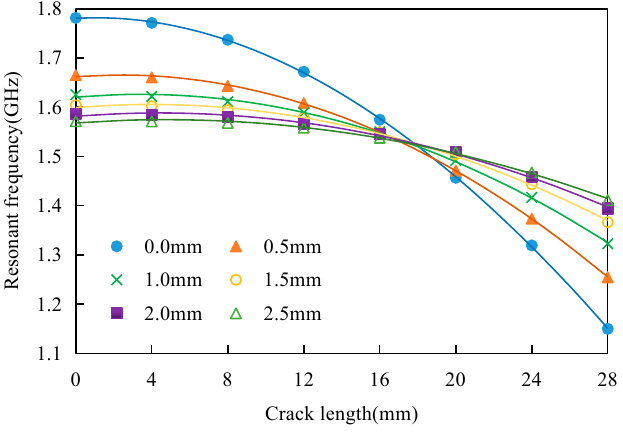
Figure 14. Relationship between resonant frequency and crack length for the different FRP thicknesses. Table 6. Polynomial fitting results for the relationship between resonant frequency and crack length. FRP Thickness (mm)